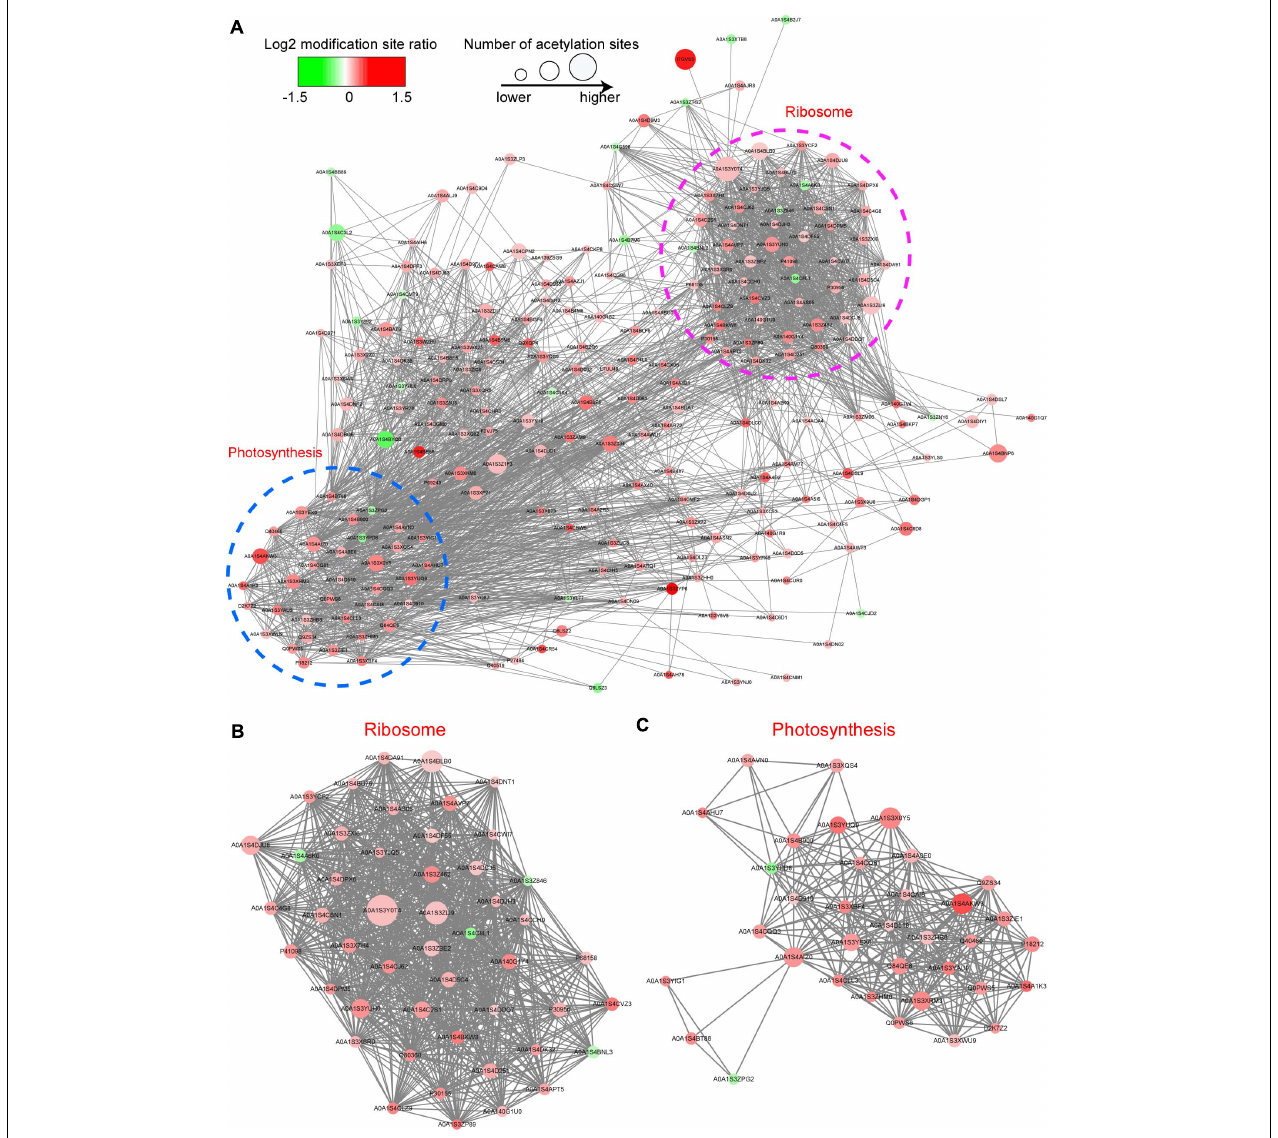
FIGURE 6 | Interaction networks of differentially expressed acetylated proteins in CWMV-infected plants compared with expression in uninfected N. benthamiana plants. (A) The entire protein–protein interaction network of acetylated proteins of CWMV-infected versus uninfected CK plants. (B) Interaction network of acetylated proteins associated with the ribosome of CWMV-infected versus uninfected CK plants. (C) Interaction network of acetylated proteins involved in the photosynthesis of CWMV-infected versus uninfected CK plants.